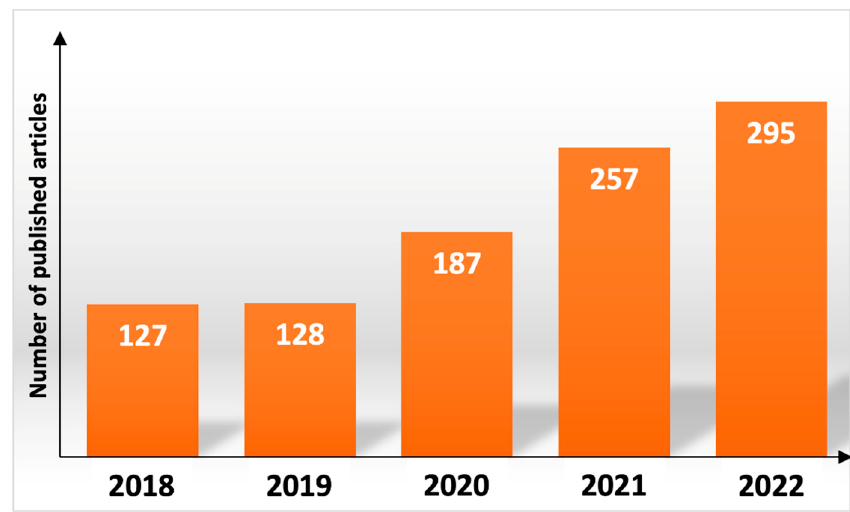
Figure 1. Number of research and review papers published in the previous 5 years according to PubMed database. The keywords used in the field Title/Abstract were: “electrospinning” or “electrospun”.